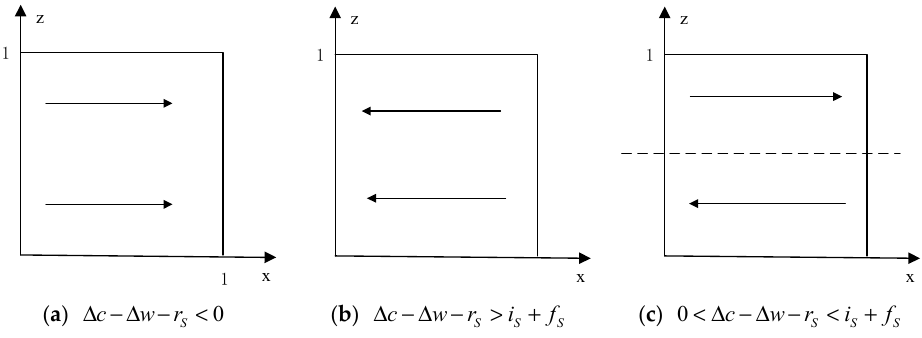
Figure 1. Evolutionary path of suppliers’ strategy.